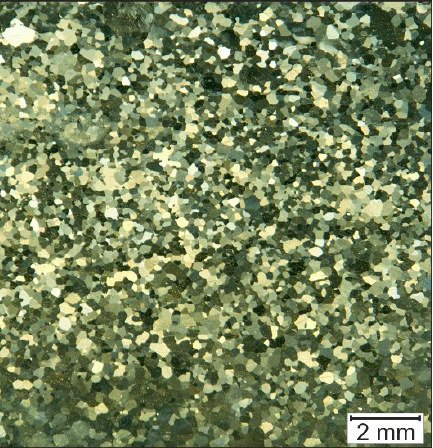
Figure 8. Microstructure of Fe38Al before ECAP forming.